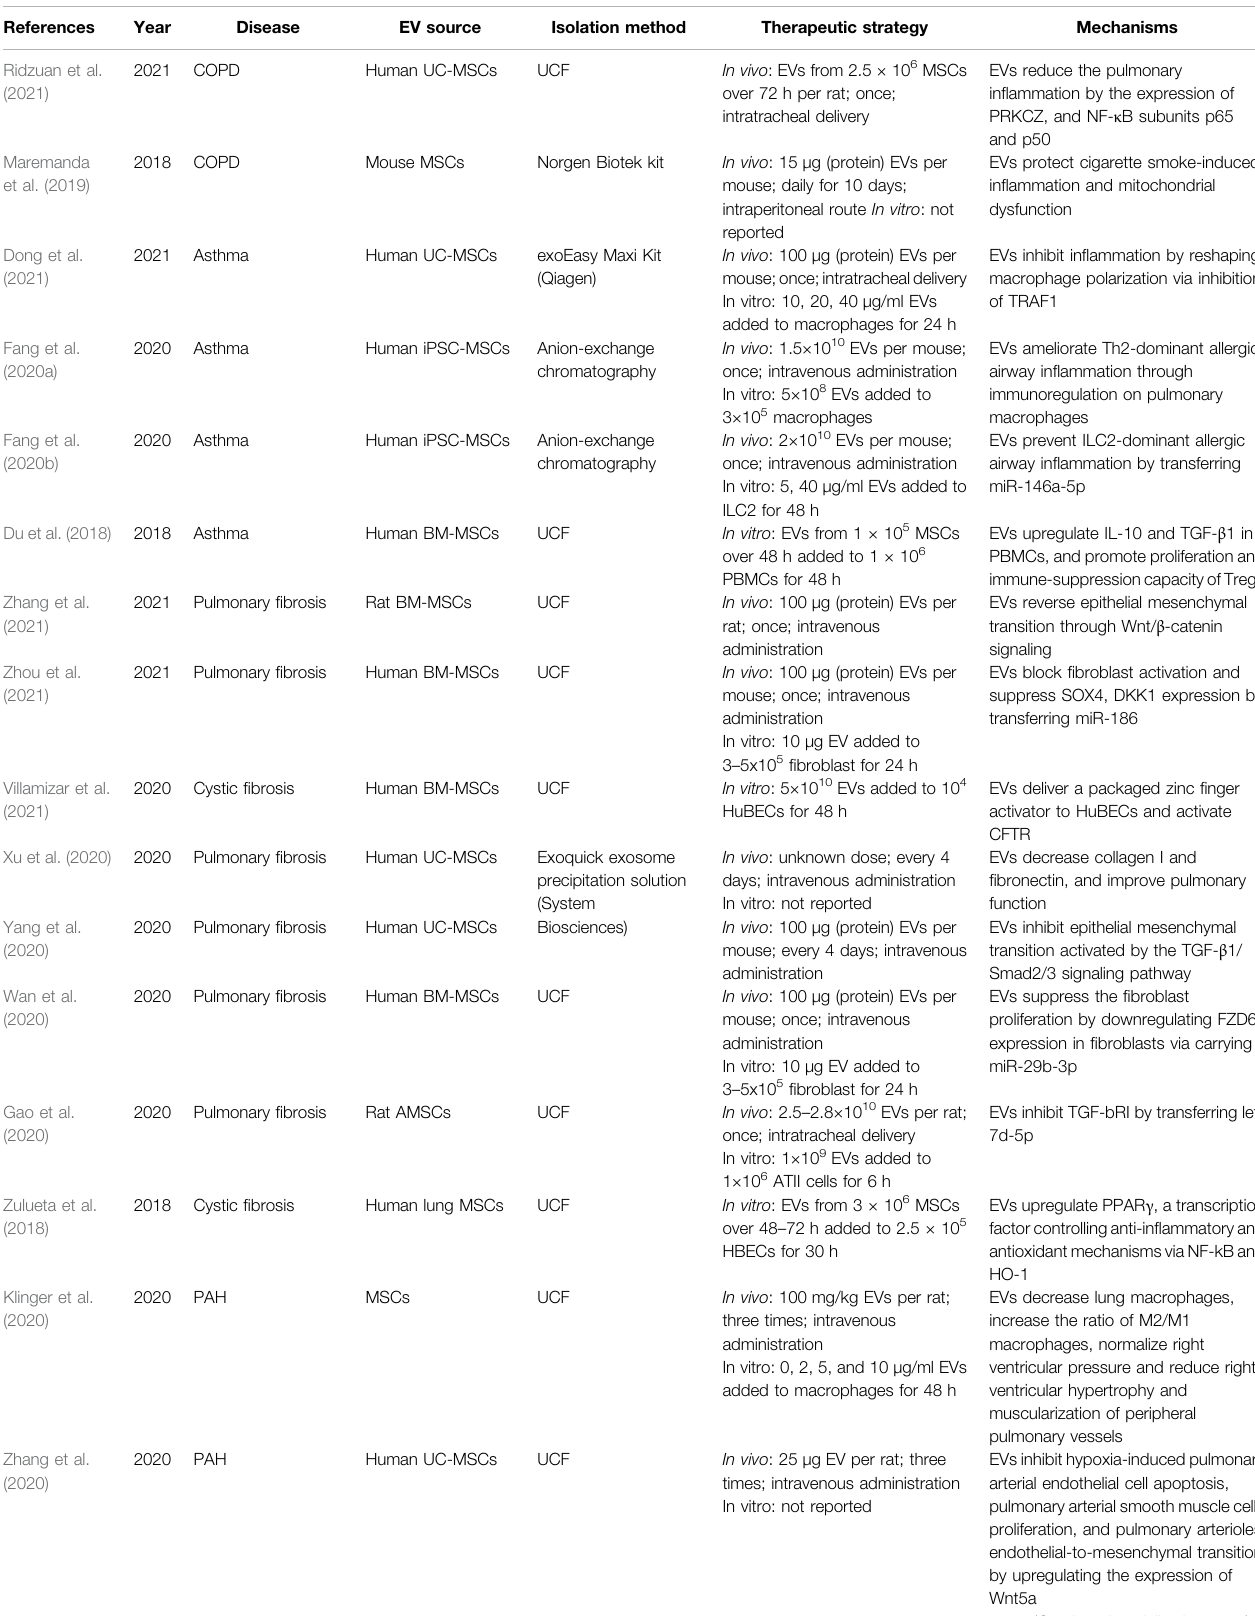
TABLE 1 | Therapeutic applications of MSC-derived EVs in chronic lung